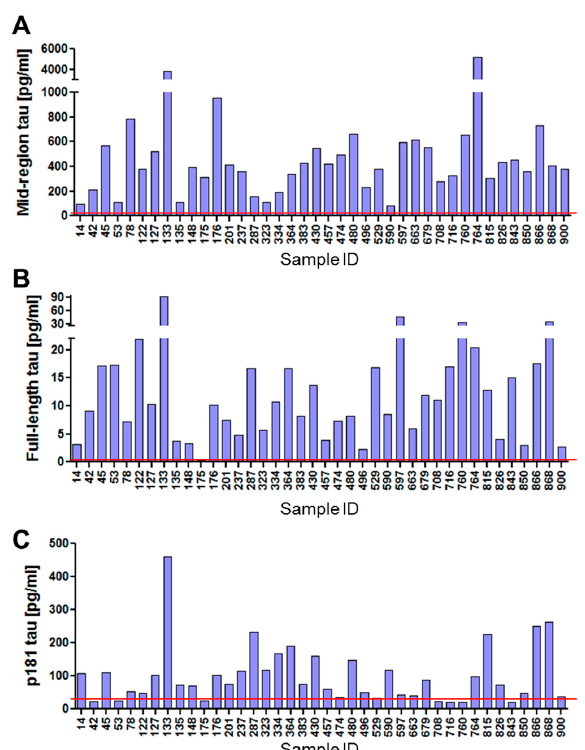
Figure 6. Blood-derived neuronal exosomes contain several different forms of tau. ( A ) Our in-house BT2-Tau5 ELISA detected tau in all plasma neuron-derived exosomes studied. On the day of testing the LLoQ for the assay was 7.81 pg/mL. ( B ) Full-length tau was detected with an in-house Simoa-based assay which on the day of testing had an LLoQ of 0.74 pg/mL. (C) The concentration of ptau-181 was measured with the Innotest commercial kit, which, on the day of testing, had an LLoQ of 24.5 pg/mL. For each assay, the LLoQ is indicated with a red line.